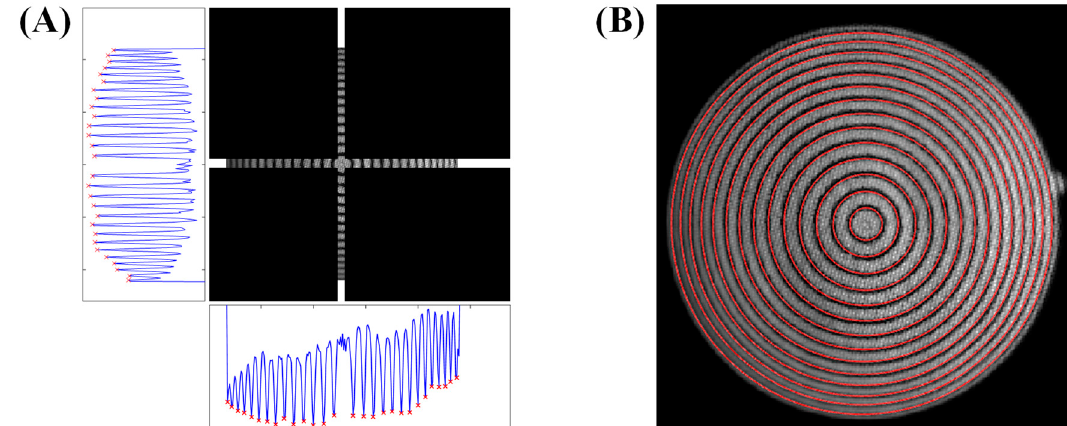
Figure 4. Segmentation of a circular grid: ( A ) strips parallel to axes with their respective summations. The red × marks denote the detected local minima, ( B ) final segmented circles after the fine-tuning stage.